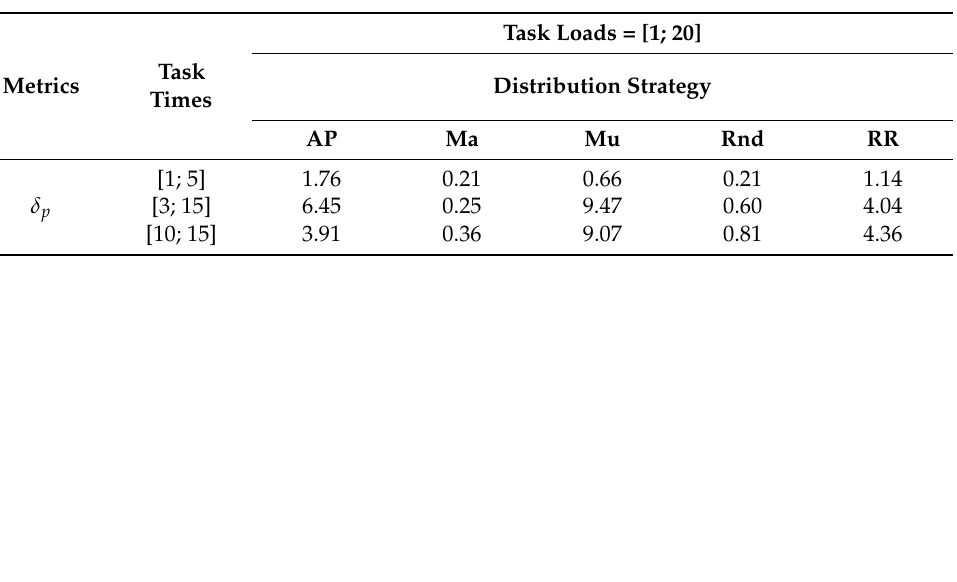
Table 3. Statistics for tasks with a low amount of required processing power and various required